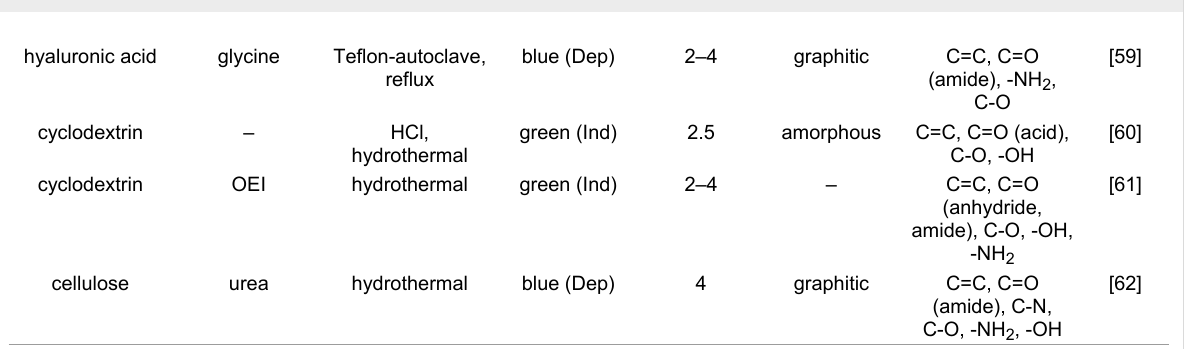
Table 1: Summary of carbohydrate-derived CDs synthetic protocols and properties. (continued)